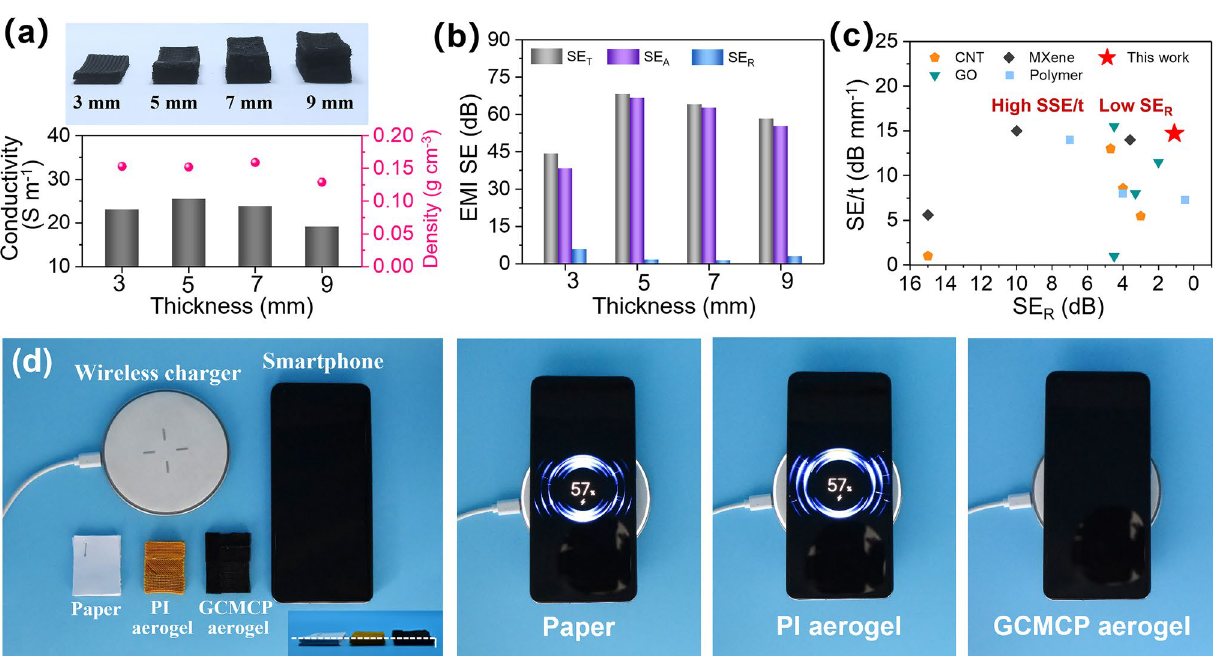
Fig. 5 Electromagnetic shielding performance of GCMCP aerogel frame with various thicknesses. ( a ) Digital photographs of GCMCP aerogel frame with 3, 5, 7 and 9 mm, and the conductivity and density as a function of thickness. ( b ) SE T , SE A and SE R value of GCMCP aerogel frame with 3, 5, 7 and 9 mm, respectively. ( c ) Comparison of normalized EMI SE and SE R with those of previously reported EMI shielding materials. ( d ) Demonstration of the EMI shielding ability of paper, PI aerogel frame and GCMCP aerogel frame for wireless